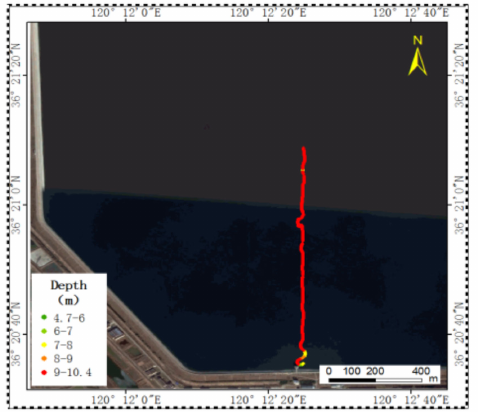
Figure 6. Mobile communication’s trajectory of